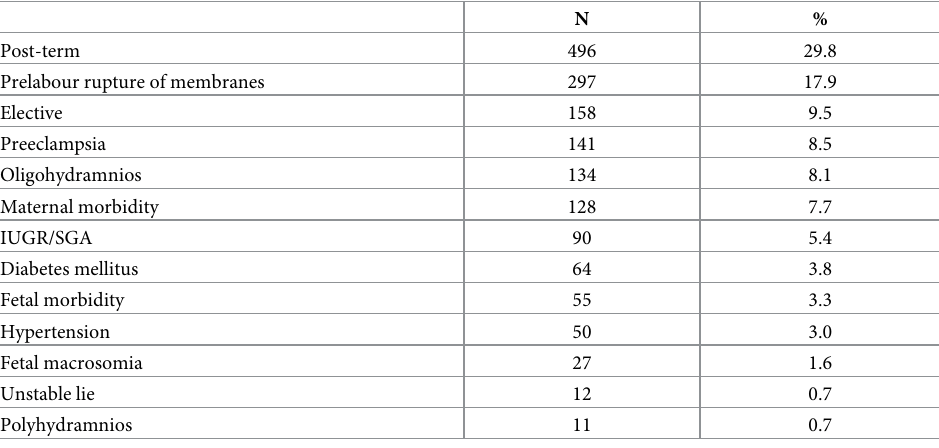
Table 2. Main indication for induction of labor (N = 1663).